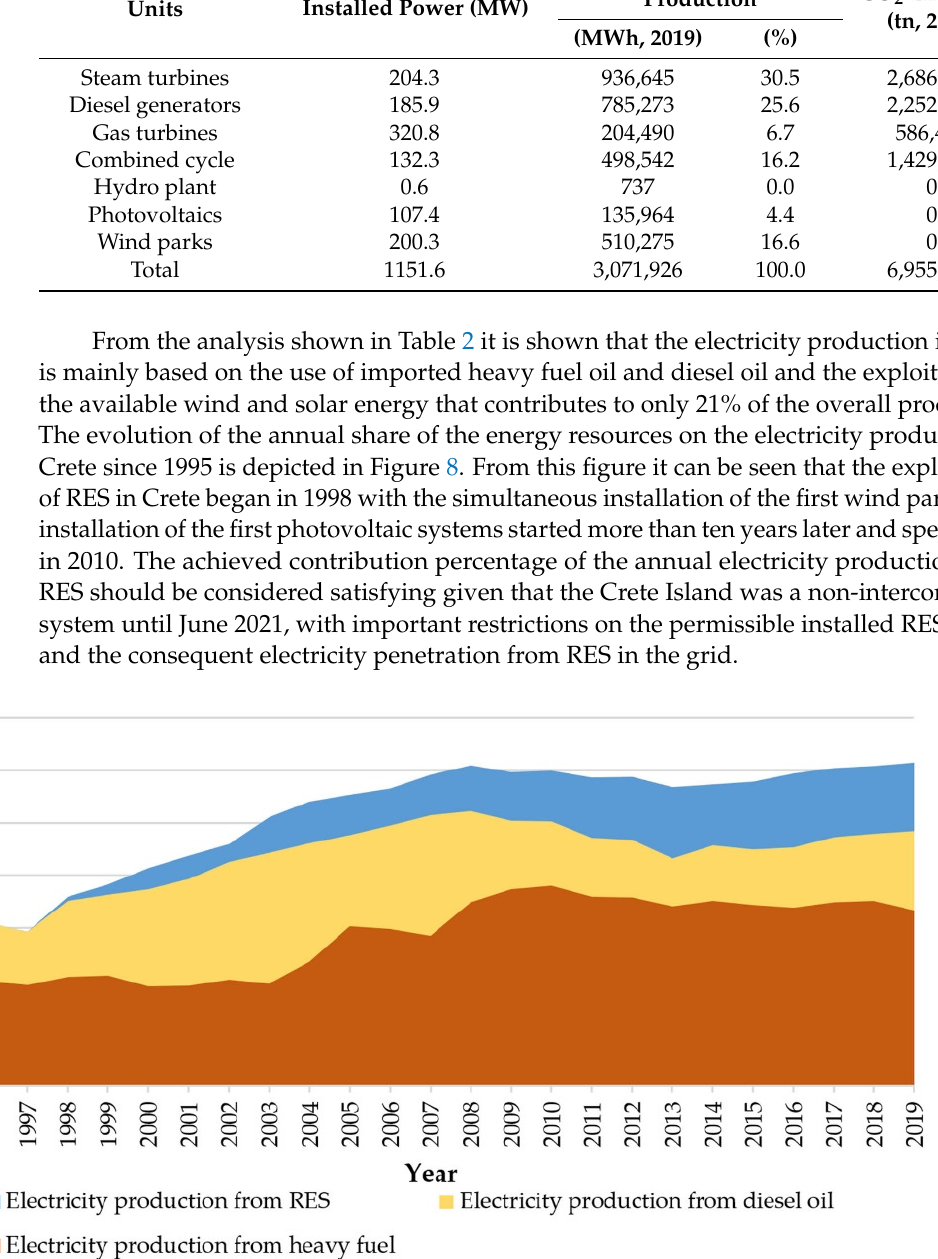
Units Installed Power (MW)